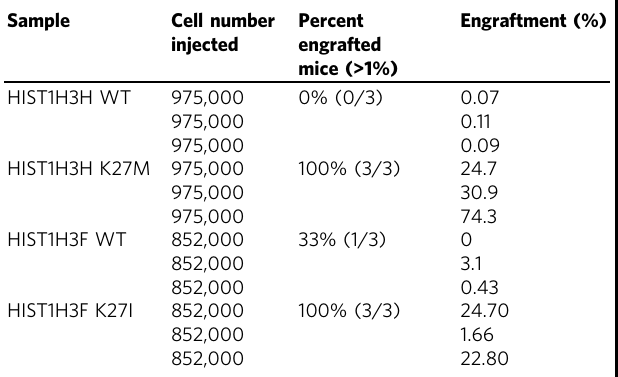
Table 3 Human CD45 + engraftment of the right femur of NSG-S mice 14 weeks after secondary transplantation with CD45 + GFP + human cord blood transduced with indicated genes Engraftment (%) Sample Cell number Percent injected engrafted mice (>1%) HIST1H3H